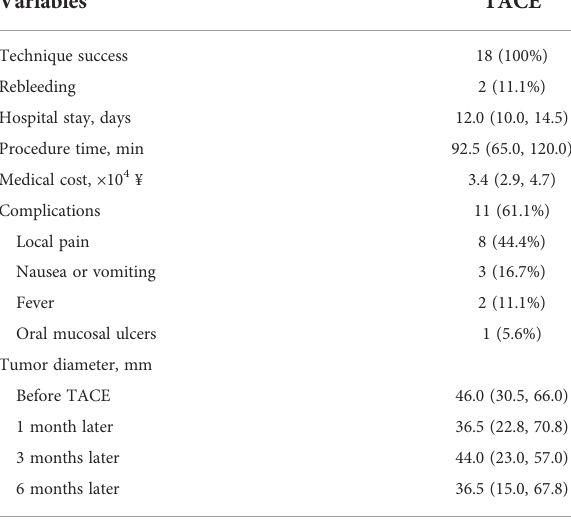
TABLE 2 Clinical data on TACE procedure and tumor diameter